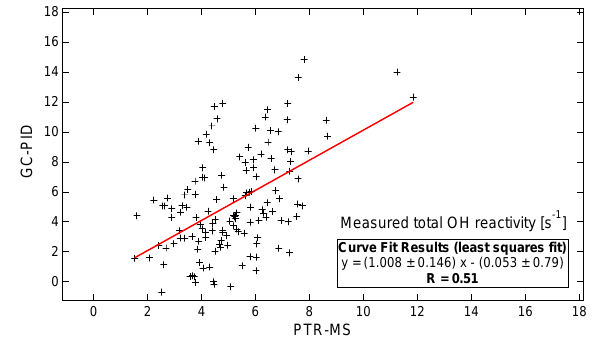
Fig. 8. Direct total OH reactivity measurements within the summer- time boreal forest canopy during HUMPPA-COPEC 2010. Both de- tectors were operated in parallel for CRM, the data were analyzed and averaged to 5min. PTR-MS (green) and GC-PID (black) show good agreement in a total OH reactivity range from the limit of de- tection to 40s − 1 . The detection limit for both instruments during this study was 3s − 1 and is highlighted in the graph as gray shaded area.